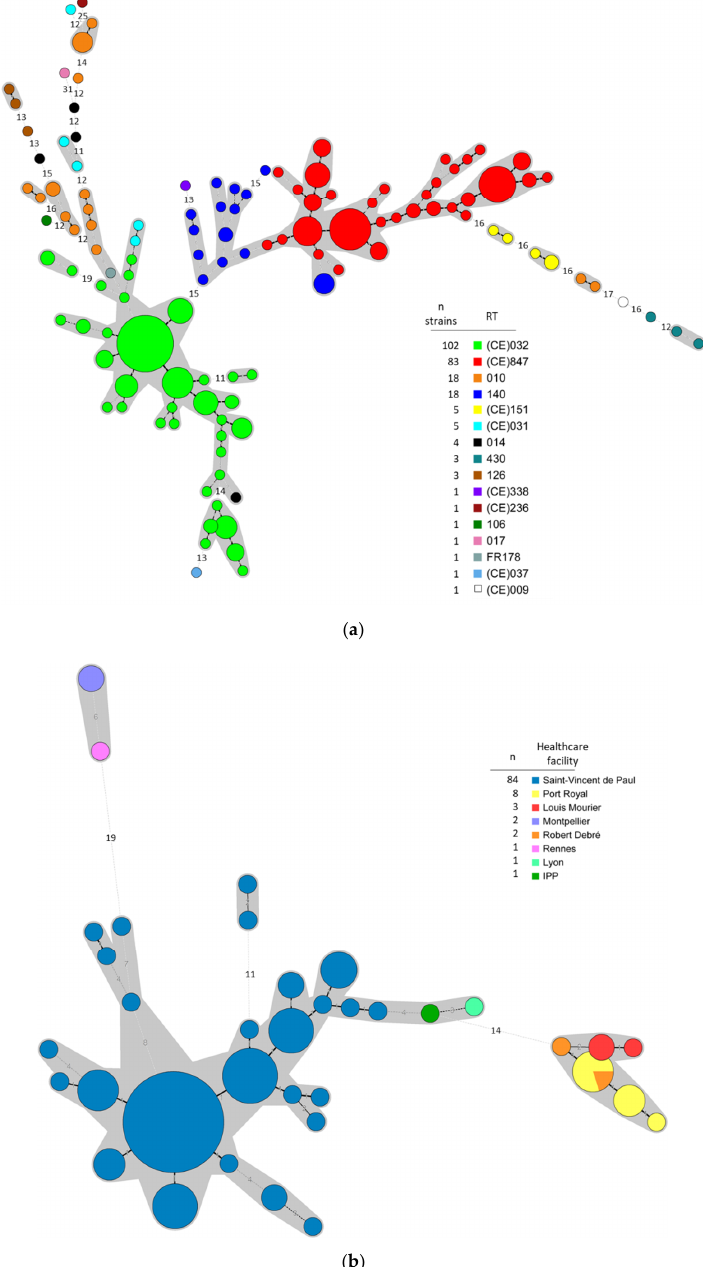
Figure 2. Minimum spanning tree representations of Multi-Locus Variable number tandem-repeat Analysis (MLVA) data of the 248 C. di ffi cile isolates ( a ) and the 102 (CE)032 isolates ( b ). The circles represent unique MLVA-types and are scaled to member count. The number between the circles represents the STRDs (summed tandem repeat di ff erences) between MLVA-types. Grey areas represent genetically related MLVA-types (STRD ≤ 10) while MLVA-types linked by a plain line are part of the same clonal complex (STRD ≤ 2). MLVA-types are color-coded according to the RT for the ( a ) and according to the healthcare facility for the ( b ). IPP: Paris child care